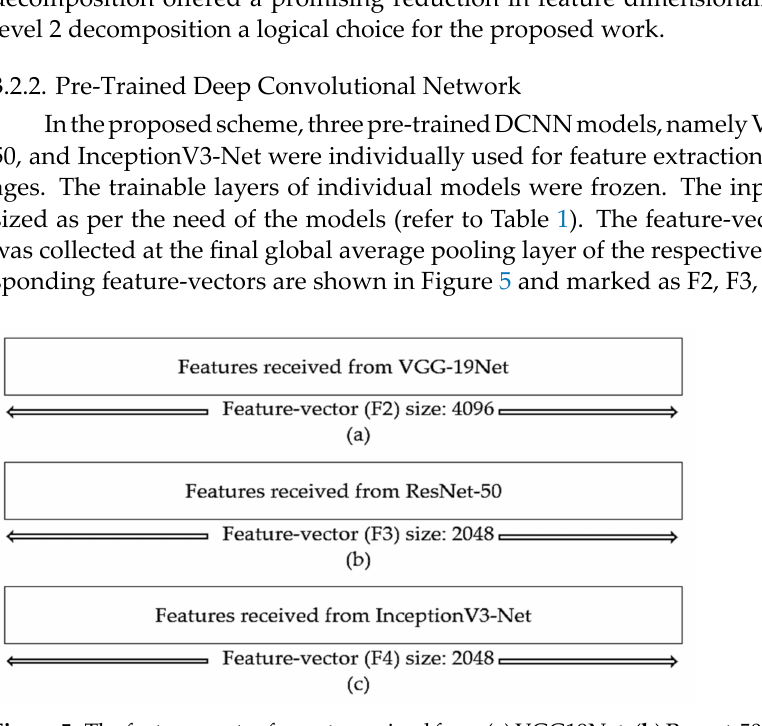
Figure5. Thefeature‑vectorformatsreceivedfrom( a )VGG19Net;( b )Resnet‑50;( c